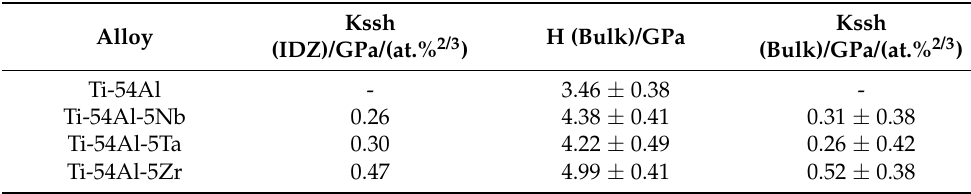
Table 4. Average values of the solid solution hardening coefficients K ssh (IDZ) of Nb, Ta and Zr determined on the diffusion couples as well as Hardness H (Bulk) and solid solution hardening coefficients K ssh (Bulk) for all investigated alloys measured on the bulk materials.